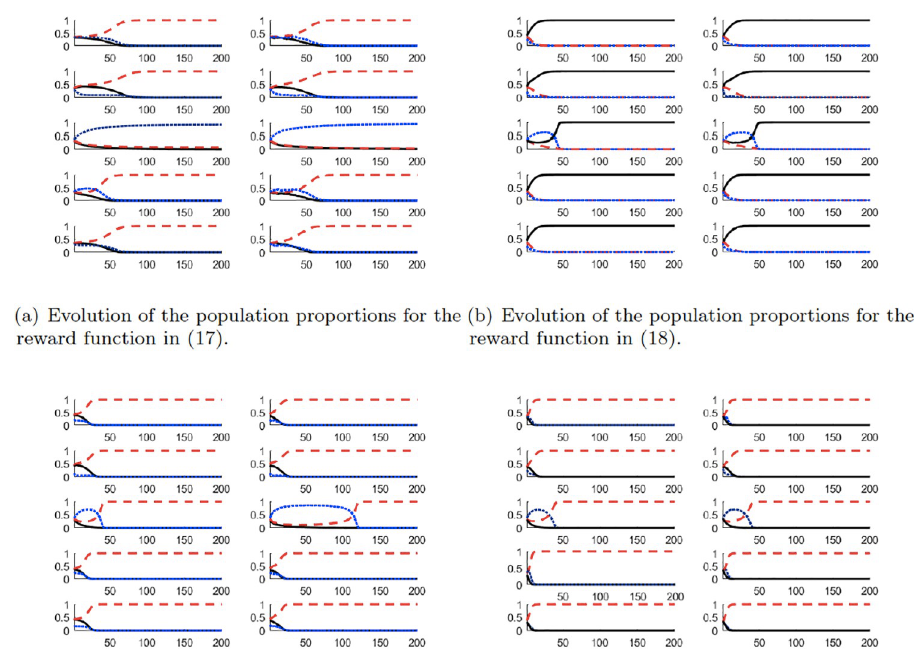
Fig 4. Simulation results. The players in X , Y and Z , are depicted as straiht, dashed and dotted lines in the figures. Each row represent one of the five cases. The left column corresponds to the results of the Markov process and the right column to the quantised consensus process. The x -axis corresponds to the iteration number and the y -axis to the distribution of the population over the three states.